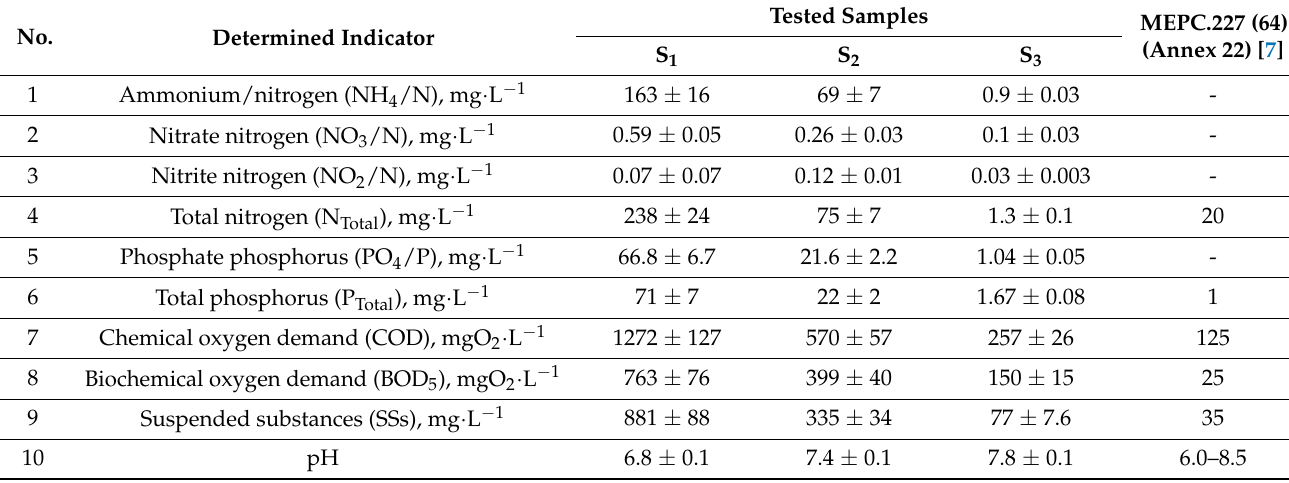
Table 2. Measurement test results and maximum values permitted by the normative requirements of the MEPC.227 (64) (Annex 22) for the outputs after sewage treatment of discharge according to the requirements of MARPOL Annex IV. No. Determined Indicator